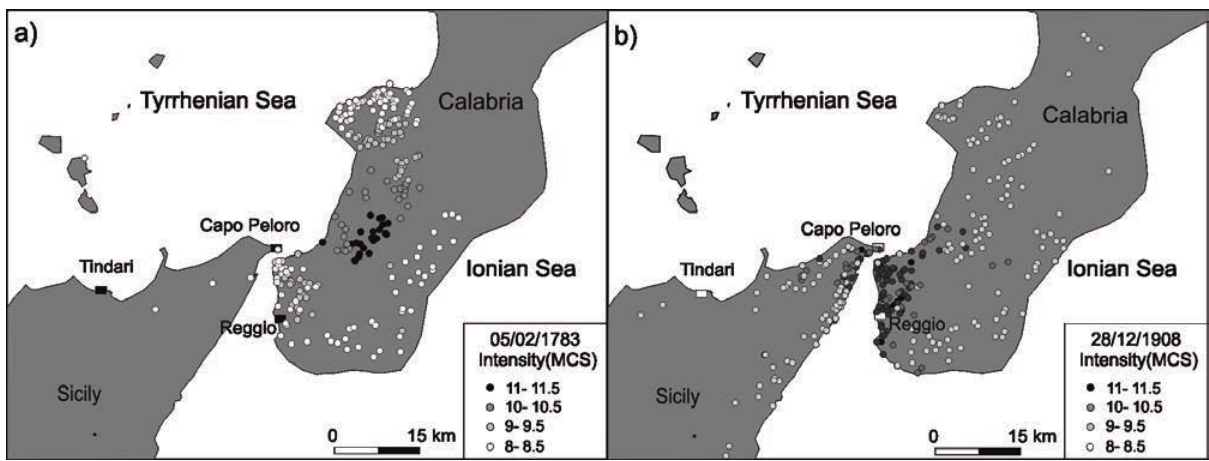
Figure 12. a) Maximum intensity data point distribution (I=8-11 MCS) for the February 5, 1783 (a) and the December 28, 1908 (b) earth- quakes [data from Boschi et al. 2000].